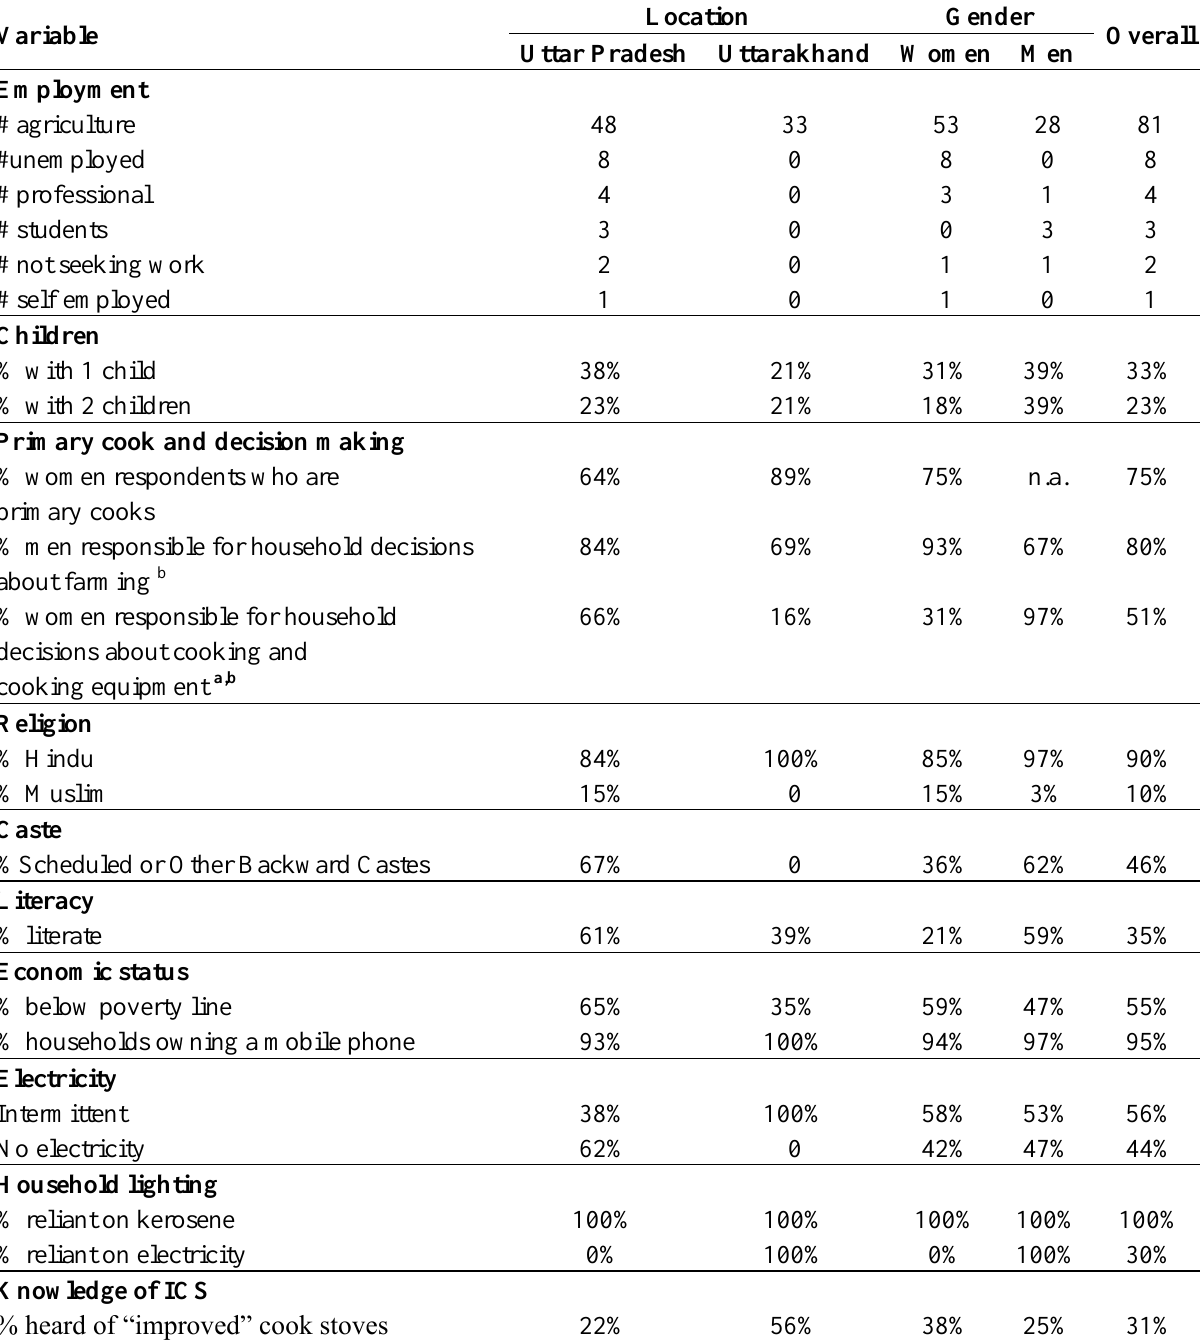
Table 2. Descriptive Statistics (individual-level questions; n =